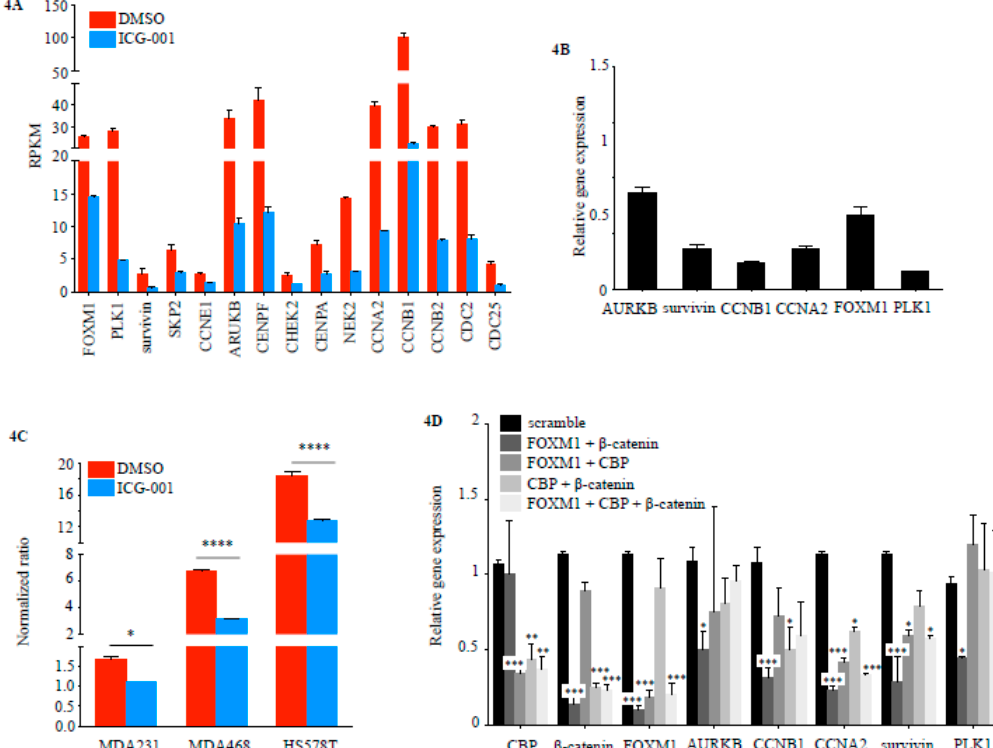
Figure 4. ICG-001 treatment effect FOXM1 transcriptional activity in TNBC cell lines. ( A ) RNA Seq. differential gene expression (RPKM) in FOXM1 target genes in MDA-MB-231 cells treated for 48 h with either 10 μ M ICG-001 or DMSO vehicle control (ICG-001 vs. DMSO, n = 2 per time point per condition). ( B ) Expression changes (RT-qPCR) in FOXM1 target genes in MDA-MB-231 cells treated for 24 h with either 10 μ M ICG-001 or DMSO vehicle control ( n = 3 per condition). ( C ) FOXM1luc Firefly/Renilla reporter for three TNBC cell lines (MDA-MB-231, MDA-MB-468, Hs578T) treated for 24 h with either 10 μ M ICG-001 or DMSO vehicle control (bars represent normalized ratios of FOXM1 Firefly luciferase to control vector Renilla luciferase expression; n = 3 per condition per cell line). (* p < 0.05, **** p < 0.0001). ( D ) Transient siRNA gene knockdown (KD) (48 h) in MDA-MB-231 cells and qPCR for FOXM1 target. (* p < 0.05, ** p < 0.01, *** p < 0.001).